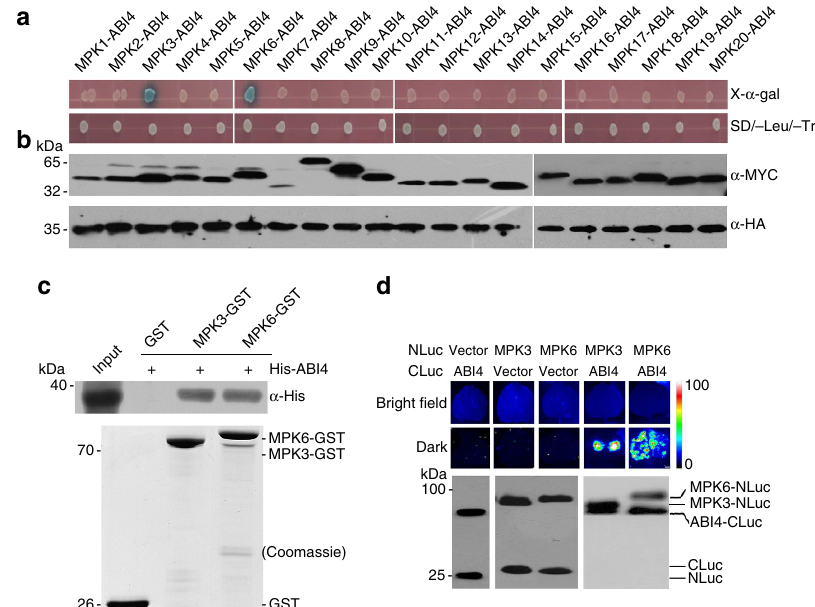
Figure 1 | ABI4 interacts with MPK3 and MPK6. ( a ) Yeast two-hybrid assay for the interaction between ABI4 and MPK3/MPK6. Fusion constructs of the ABI4 (amino acids 1–160) fused with the GAL4 DNA-binding domain (BD) and 20 MAPKs fused with the GAL4 activation domain (AD) were co-transformed into Y2H Gold yeast cells. These strains were grown on SD-Leu-Trp medium (bottom) and subjected to a -galactosidase assay (top). ( b ) Immunoblot analysis of target fusion proteins in the yeast two-hybrid assays indicated in ( a ) using HA tag and Myc tag antibodies, respectively. ( c ) Pull-down assay for the interaction of ABI4 with MPK3/MPK6. His-tagged ABI4 was incubated with immobilized GST or GST-tagged MPK3/MPK6. After washing, bound proteins were eluted and subjected to immunoblot analysis using an antibody against His. Coomassie blue (CBB) staining indicates equal amounts of bait proteins. ( d ) Luciferase complementation imaging assay for the interaction of ABI4 with MPK3/MPK6. N. benthamiana leaves were co-infiltrated with the agrobacterial strains harbouring the construct pairs of ABI4-CLuc and MPK3/MPK6-NLuc. ABI4-CLuc and NLuc as well MPK3/MPK6-NLuc and CLuc were used as controls. The images were taken after 48h of infiltration. Bright luminescence indicates direct protein–protein interactions and the pseudocolour bar shows the range of luminescence intensity in the images. The western blot below shows the expression levels of CLuc- and NLuc-fusion proteins using anti-full-length firefly LUC antibody. Scale bar, 1cm. with that of the non-phosphorylated counterparts 29 . As shown in Fig. 2f, phosphorylation of ABI4 was induced in the MKK5 DD background, but not in MKK5 KR plants, after DEX treatment, as indicated by the upshift of the protein bands. The band shifts of ABI4 were abolished after treatment with calf intestine alkaline Ser-114 and Ser-130, designated as T111, S114 and S130, phosphatase (CIAP), demonstrating that the additional bands respectively) (Fig. 2a). In vitro phosphorylation assays showed with reduced mobility indeed result from phosphorylation that ABI4 was strongly phosphorylated in the presence of (Fig. 2g). Such upshift was also absent when changes of all the activated recombinant MPK3 and MPK6 (Fig. 2b,c). To identify three corresponding residues to Ala (ABI4 AAA ) in ABI4 under the MKK5 DD background after DEX treatment (Fig. 2h), again which amino-acid residues are responsible for phosphorylation, indicating that the identified MAPK phosphorylation sites were recombinant ABI4 proteins were mutated by replacing Ser (S) or subject to phosphorylation. Together, these results indicate that Thr (T) residues with Ala (A) and used as substrates for in vitro ABI4 could indeed be phosphorylated on MPK3/MPK6 activation MAPK phosphorylation assays. Changes of all the three both in vitro and in vivo . corresponding residues to Ala (ABI4 AAA ) in ABI4 led to a loss of phosphorylation whereas MPK3/MPK6 was still able to phosphorylate various single and double mutants (Fig. 2d,e). These results indicate that ABI4 is a substrate of MPK3/MPK6 and that the T111, S114 and S130 are independent MPK3/MPK6 phosphorylation sites. To further test whether phosphorylation of ABI4 is dependent on MPK3 and MPK6 activities in vivo , we expressed a ABI4–GFP fusion protein in the conditional gain-of-function MKK5 DD and loss-of-function MKK5 KR transgenic plants 28 , in which activation of MPK3/MPK6 is constitutively induced and abolished following DEX treatment, respectively (Supplementary Fig. 2). Phosphorylation of ABI4 was subsequently investigated by Phos-tag gel blot analysis with an anti-GFP antibody. In the gel containing Phos-tag, the phosphorylated proteins specifically binds to the Phos-tag reagent and cause a mobility shift compared NATURE COMMUNICATIONS|7:12173|DOI: